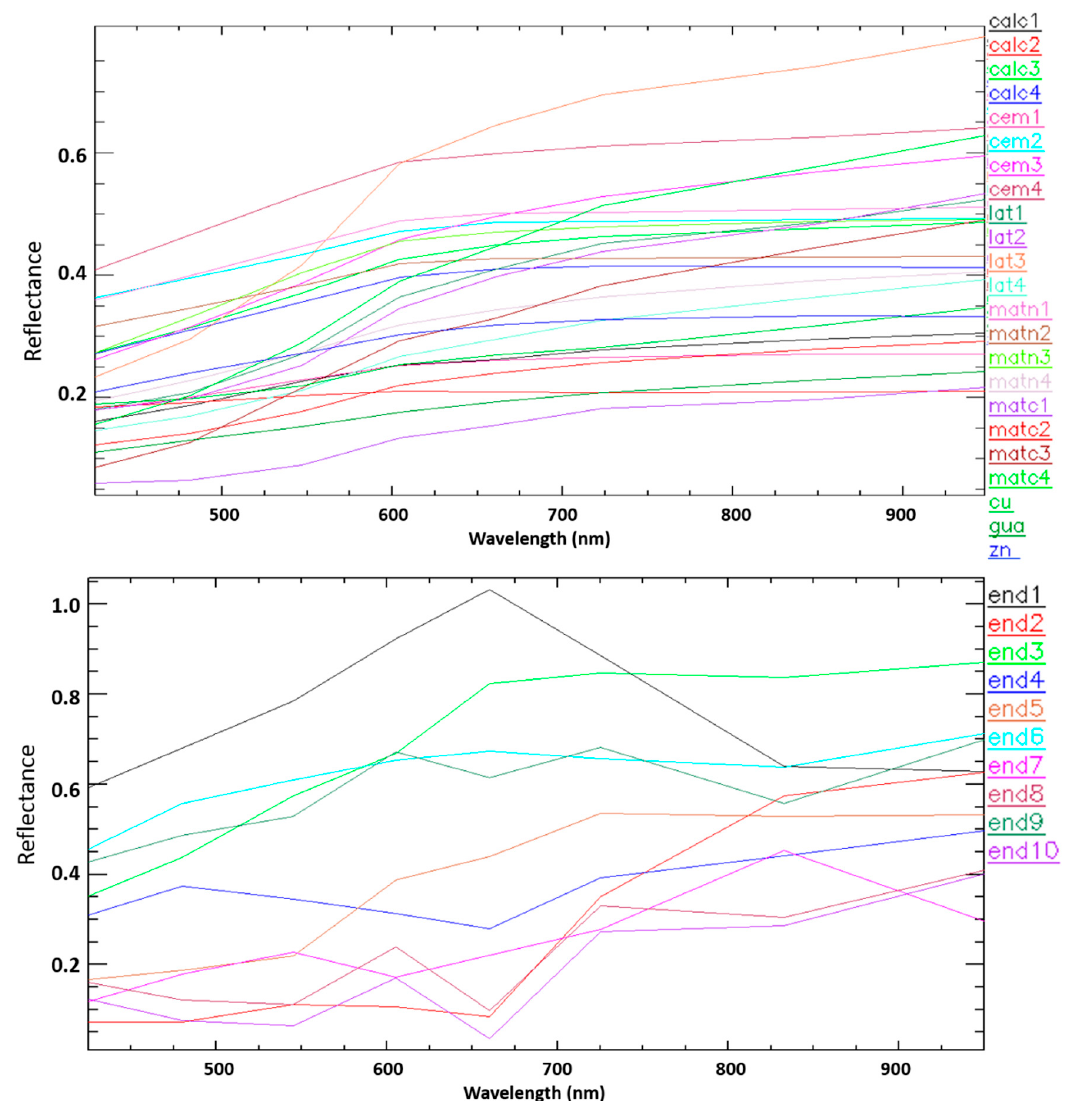
Figure 4. Resampled multispectral signatures of the 23 in situ rubble materials ( upper graph ); Multispectral signatures of endmembers extracts using SMACC algorithm ( lower graph ).